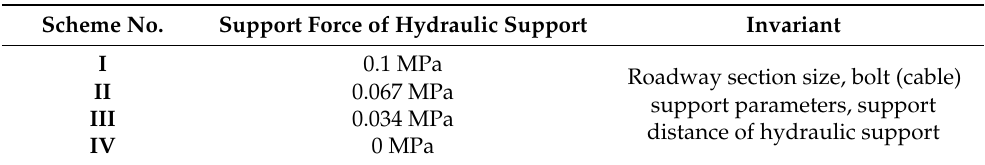
Table 1. Numerical test scheme of the advance support mechanism.